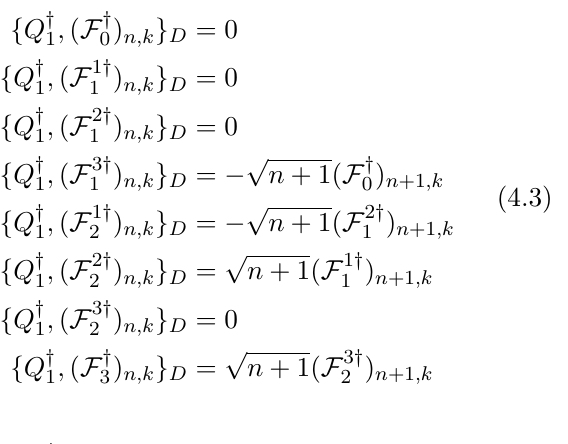
Figure 3 . Action by supercharges on the blocks B . The blue lines represent the transformation Q † while the green lines are the transformation of supercharge S in the same